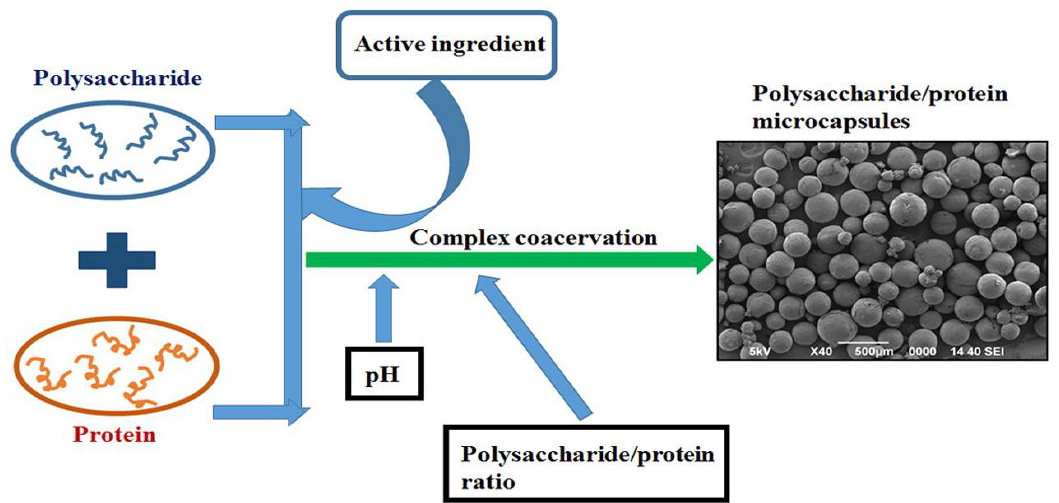
Figure 2. Complex coacervation process showing the combination of protein and polysaccharide (reproduced with permission from [84,85]. Copyright Elsevier, 2010 and 2017).